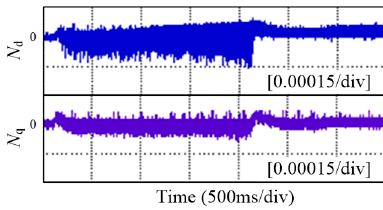
Figure 10. Experimental waveform of N d , N q in the improved UDE-based control strategy.